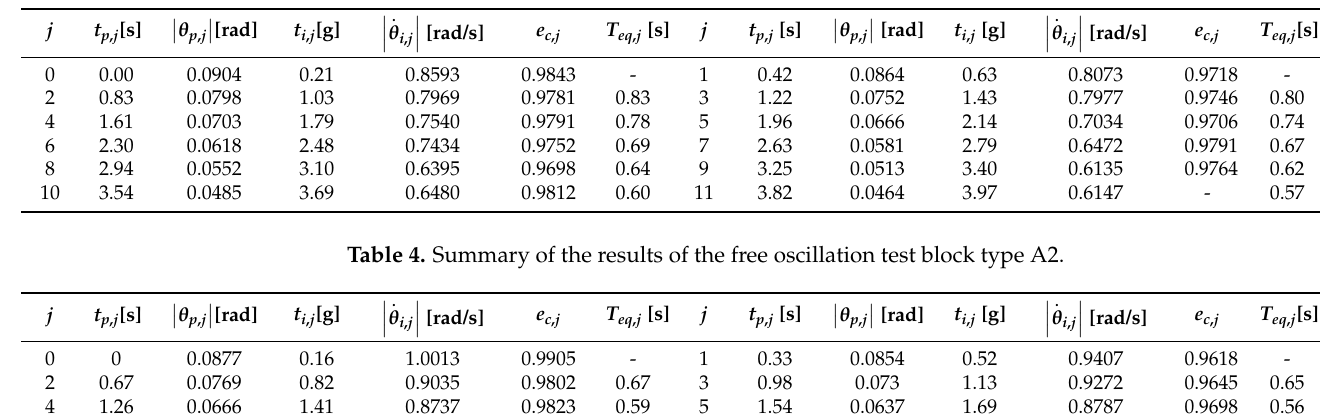
Table 3. Summary of the results of the free oscillation test block type A1.